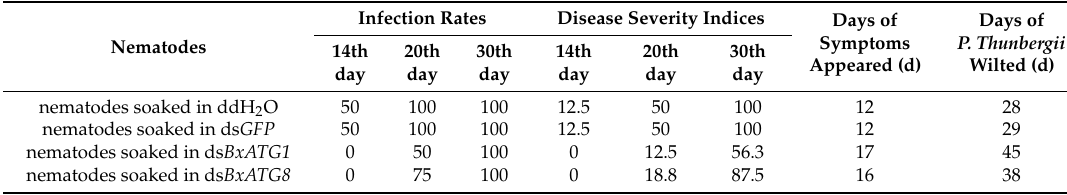
Table 1. The symptoms of P. thunbergii inoculated with PWN.